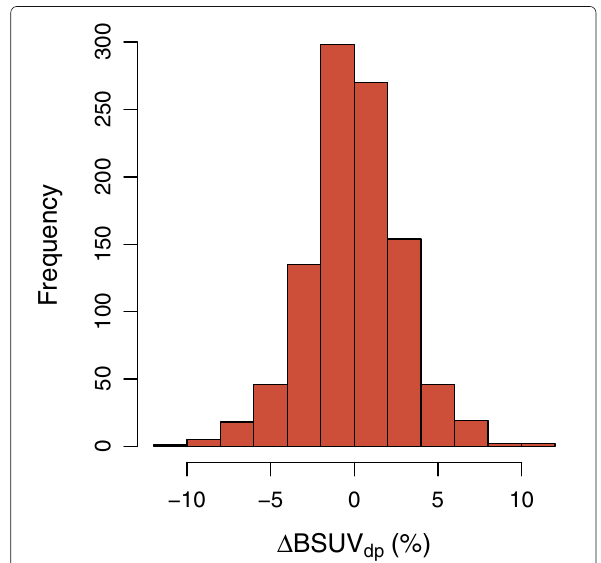
Fig. 7 Histogram of pooled interobserver variability, (cid:2) BSUV dp , expressed as fractional deviation from observer mean for the respective patient (see Eq.